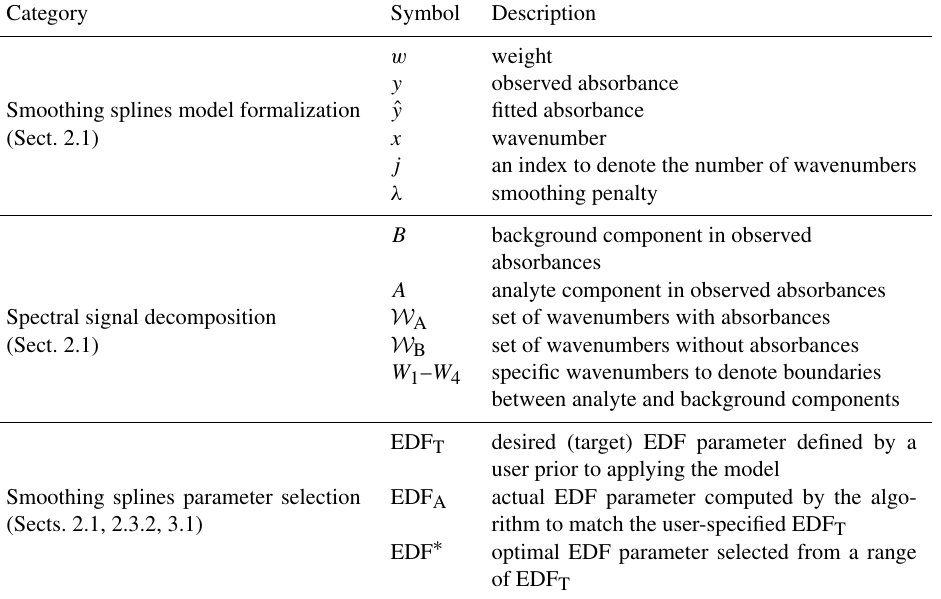
Table 1. Notation for variables